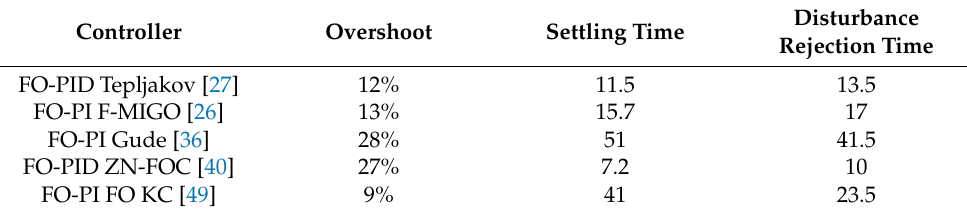
Disturbance Rejection Time